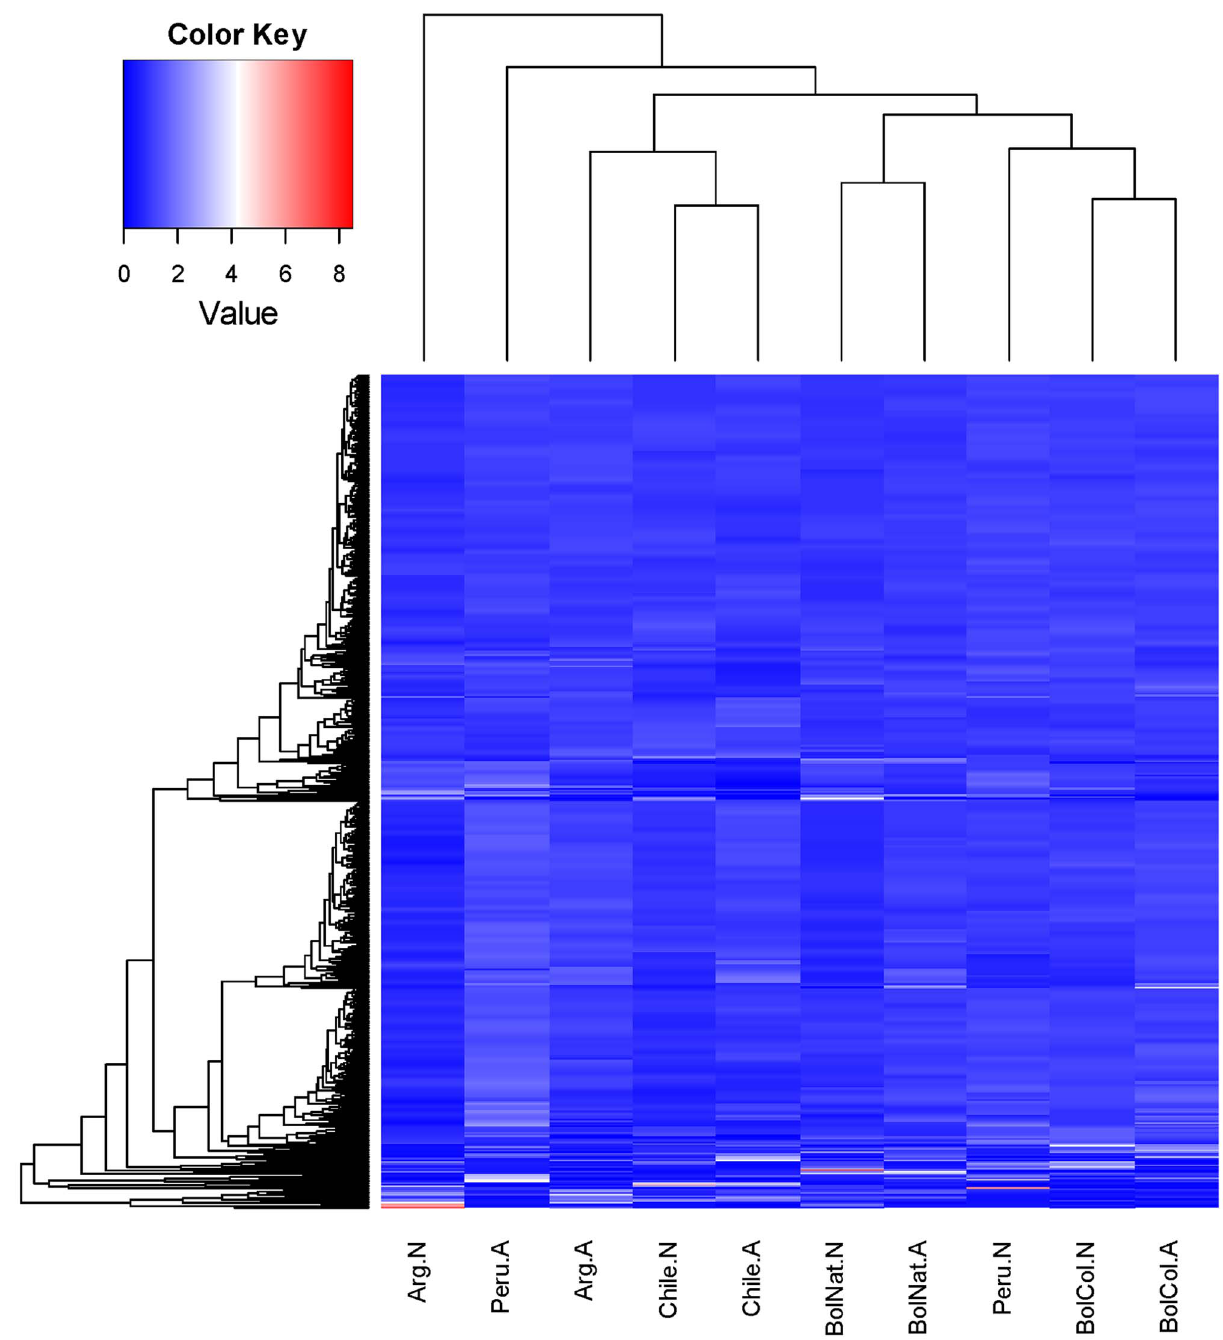
Figure 1. Z score normalized heat map of the RPKM values of the 10 triatomine libraries. Results show only CDS having an overall RPKM equal or greater than 20, totaling 4,207 CDS for the Chilean (Chile), Argentinian (Arg), Peruvian (Peru), Bolivian F1 (BolNat) and Bolivian colony (BolCol)-derived libraries from adults (.A) or nymphal (.N) organisms.